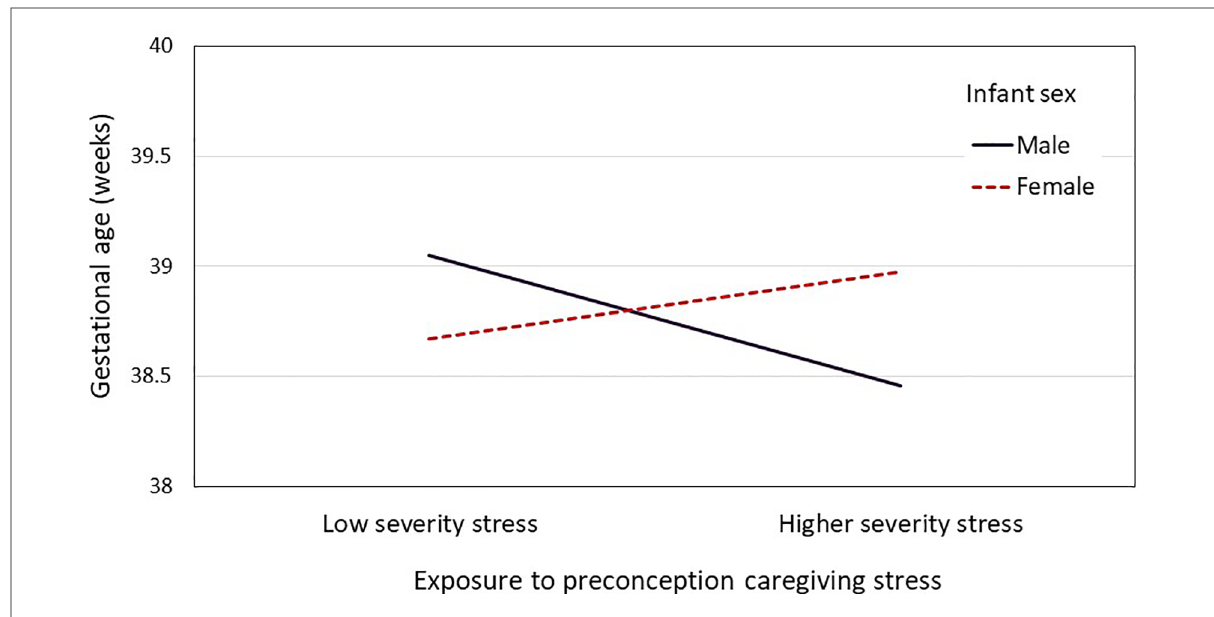
FIGURE 2 A two-way interaction plot (infant sex and preconception stress severity) for the mean gestational